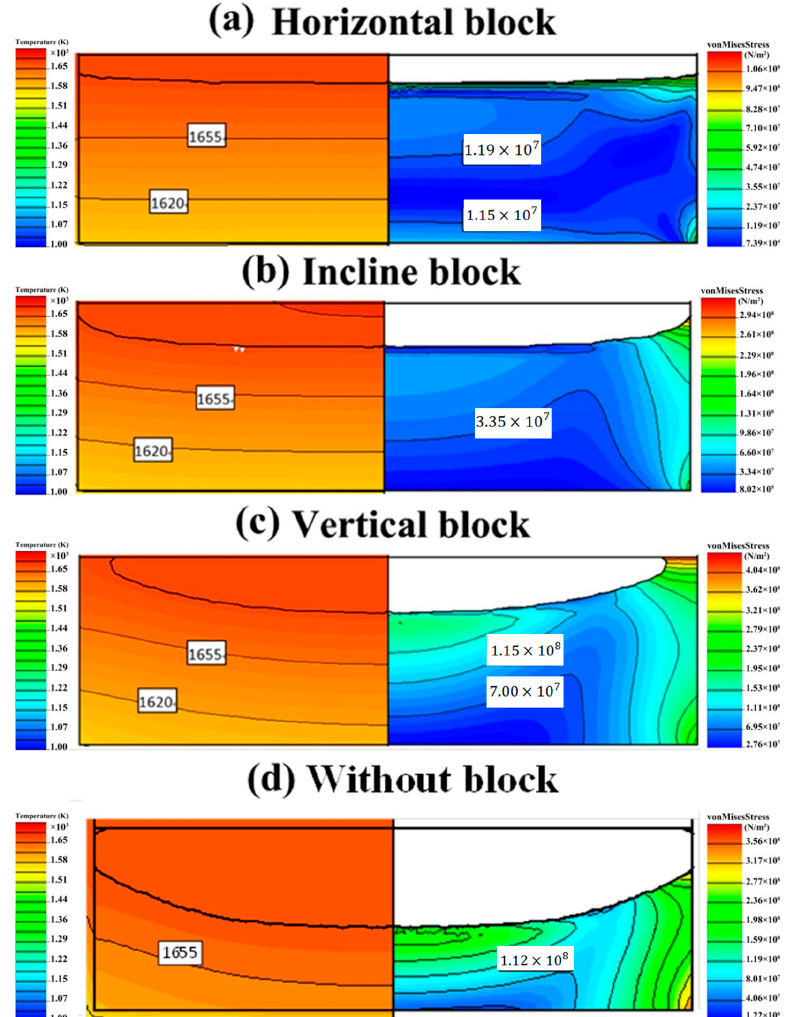
Figure 12. ( a – d ) Temperature distribution and thermal stress for di ff erent block positions at the end stage.